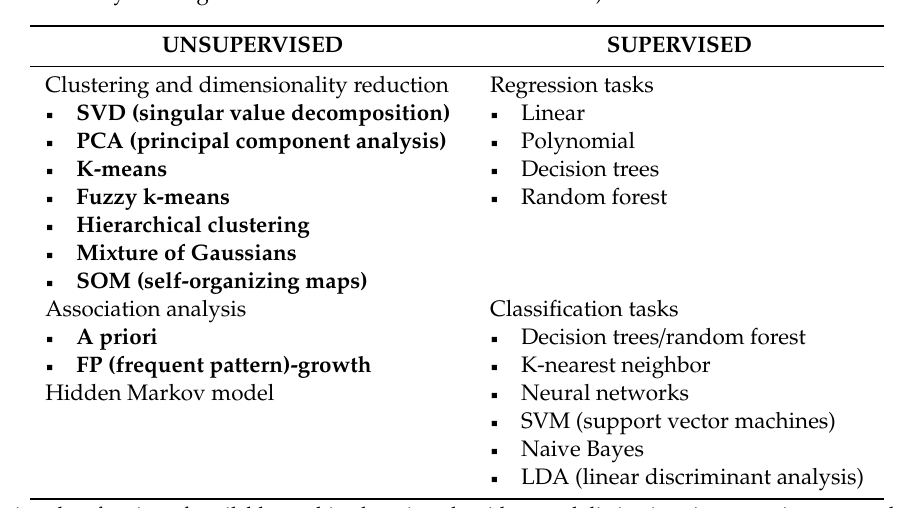
Table 1. Simplified presentation of the possible use of different machine learning algorithms (also based on already existing and well-established statistical models)* .